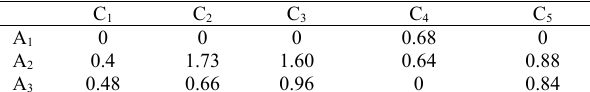
Table 9. The separation measures of individual criteria to their negative ideal solution.